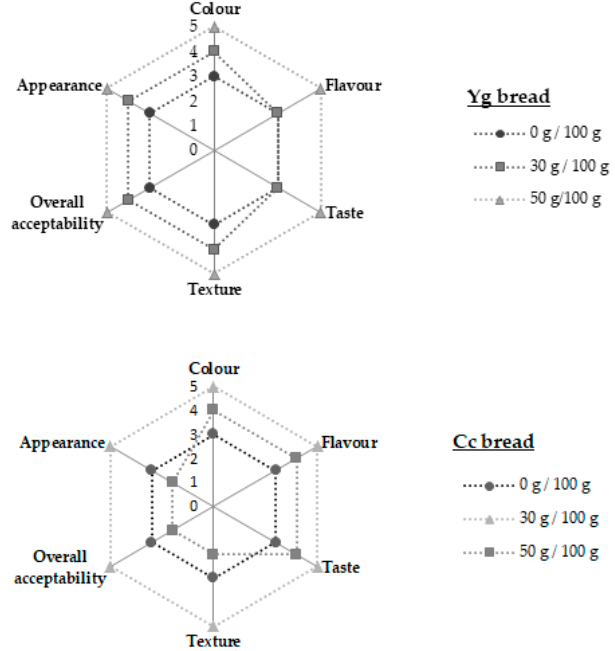
Figure 6. Sensory profile analysis of breads enriched with yoghurt ( A ) and curd cheese ( B ), with 30 g and 50 g of addition, compared with control bread (0 g/100g).